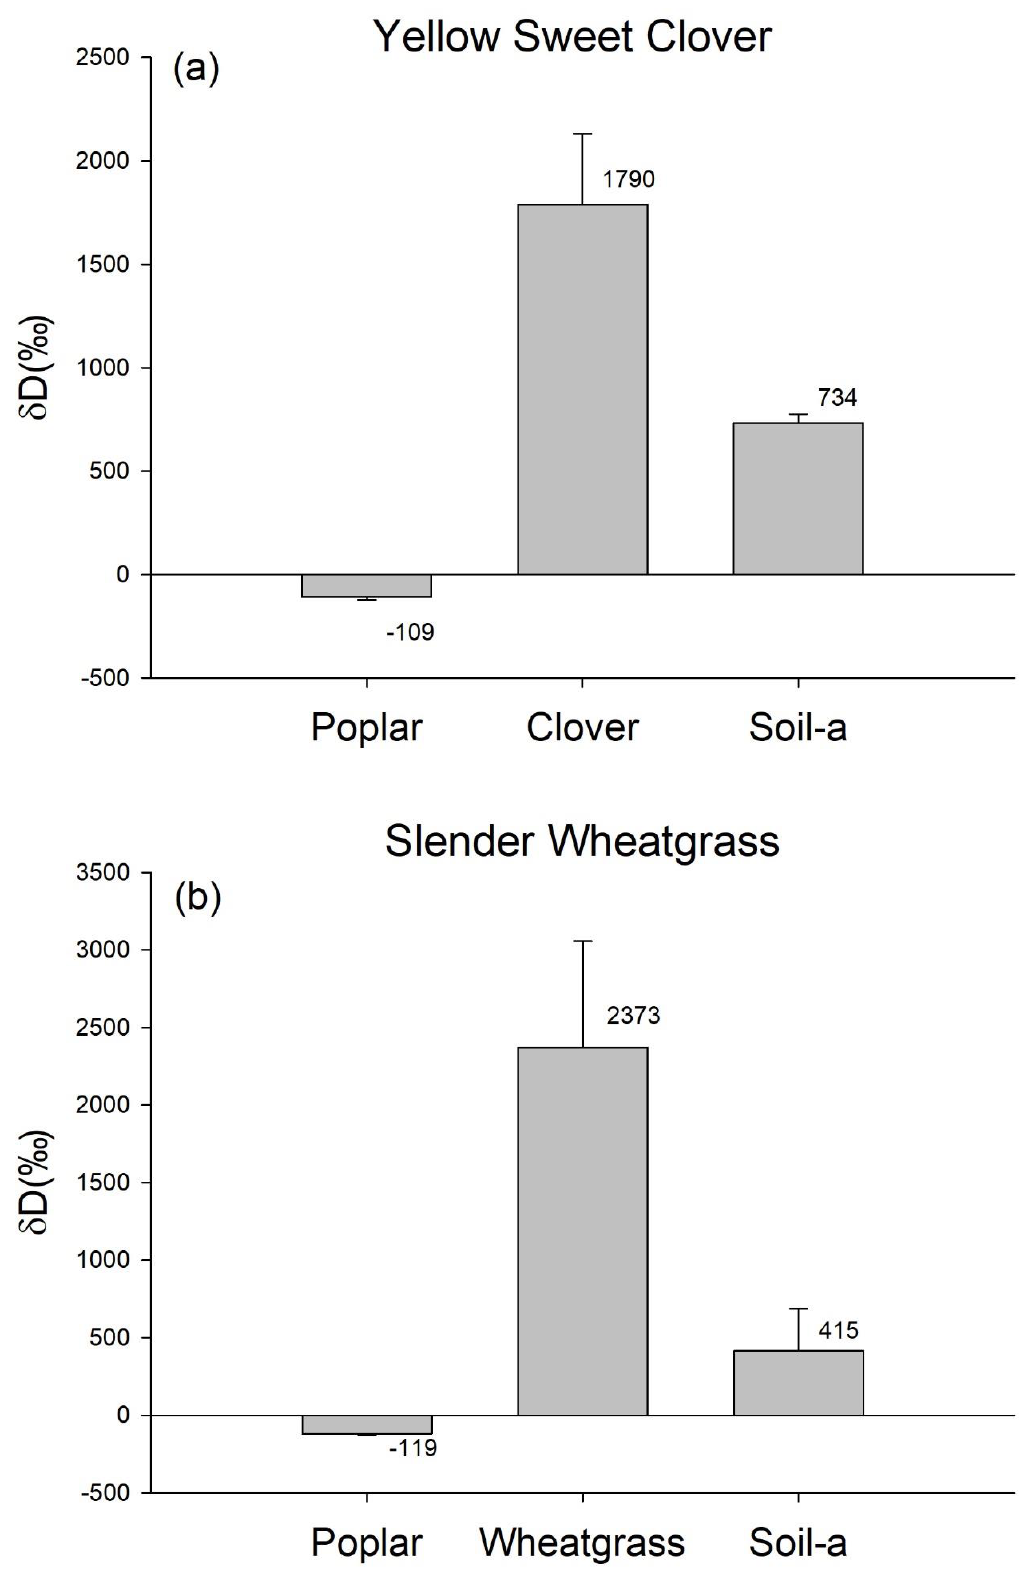
Figure 5. Hydrogen isotope ratios ( δ D) of the extracted water from soil in the upper tube (soil-a), poplar leaves, and leaves of the yellow sweet clover ( a ) and slender wheatgrass ( b ) in Study 2, when the lower tube (tube-b) was placed in the deuterium-enriched water. The δ D of control water was −220‰. Means ± SE ( n = 3) are shown.